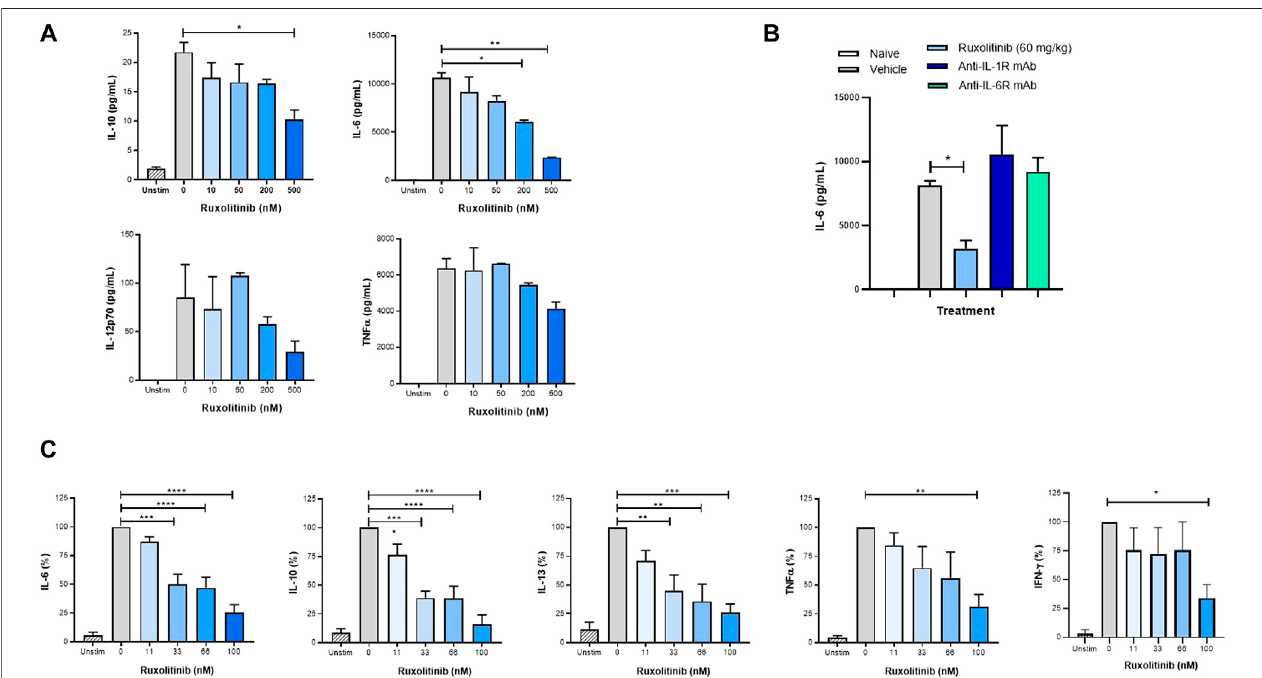
FIGURE 4 | Ruxolitinib lowers cytokine production by murine macrophages and human PBMCs (A) Bone marrow – derived macrophages were expanded in vitro with granulocyte-colony stimulating factor, and ruxolitinib was added to the cultures 24 h in advance of being activated with 5 ng/ml LPS. Culture supernatants were collected24 hpost-LPSstimulation,andmultiplexcytokineanalysiswasperformed (B) C57BL/6micewereprophylacticallydosedwithvehicle,ruxolitinib,anti-IL-1R,or anti-IL-6R for 3 days before intraperitoneal LPS injection. Cytokines were measured from peritoneal lavages 2 h after injection. Data are representative of two independent experiments. * p < 0.05, ** p < 0.01 (C) PBMCs from healthy volunteers were stimulated in vitro with anti-CD3 and anti-CD28 antibodies and increasing concentrations of ruxolitinib. Seven days later, supernatants were collected, and cytokines were measured by multiplex cytokine analysis. Data are normalized to individual donors.* p <